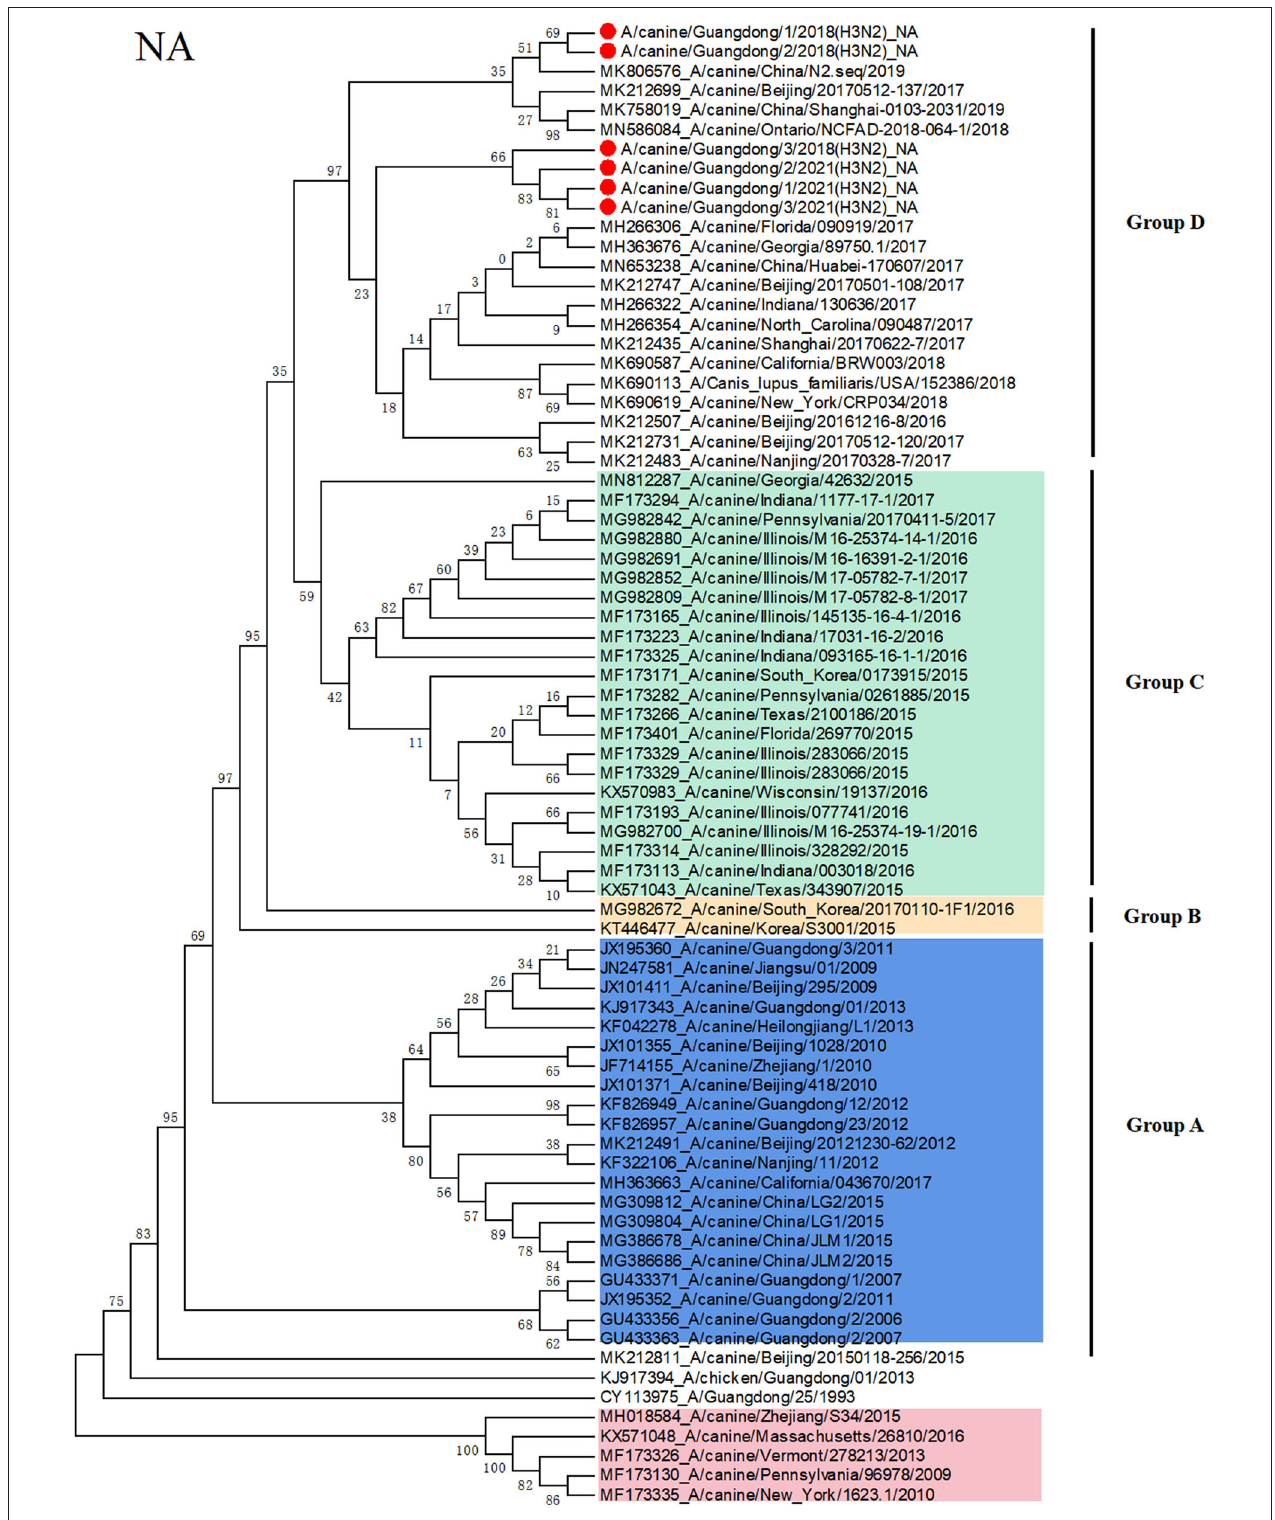
FIGURE 2 | Phylogenetic analysis of H3N2 CIV based on the NA protein. Colors indicate H3N8 CIV (red) and isolates from different geographical regions of H3N2 CIV originating from the United States (green), Korea (yellow), and China (blue). The six Chinese strains sequenced in this study are indicated by red circles.